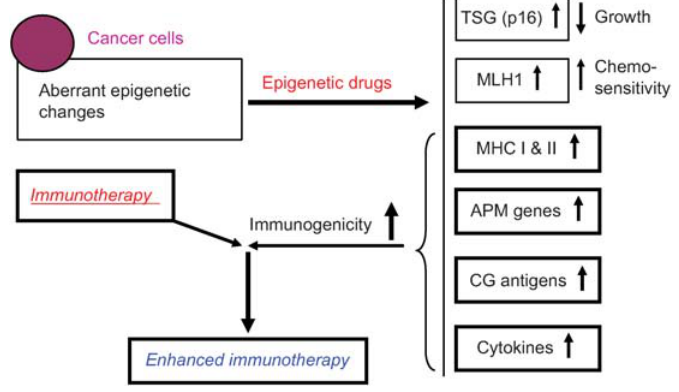
Figure 2 A model for enhanced therapeutic efficacy by combining epigenetic therapy with other therapies. Cancer cells possess aberrant epigenetic modifications. Treatment with epigenetic drugs (such as inhibitors of DNMT, HDAC and HDM) leads to corrections in the epigenome of the cancer cells. The key effects include the reactivation of TSGs (such as p16) that inhibit tumor growth and DNA repair genes (such as MLH1) that increase sensitivity to chemotherapy. The treatment in many cases also enhances tumor immunogenicity by restoring expression of MHC class I and II antigens, other antigen processing and presentation machinery (APM) components (e.g., TAP proteins), inflammatory cytokines and CG antigens, as well as antigens expressed from activated transposons and endogenous retroviruses (123). These effects result in increased sensitization of cancer cells to subsequent